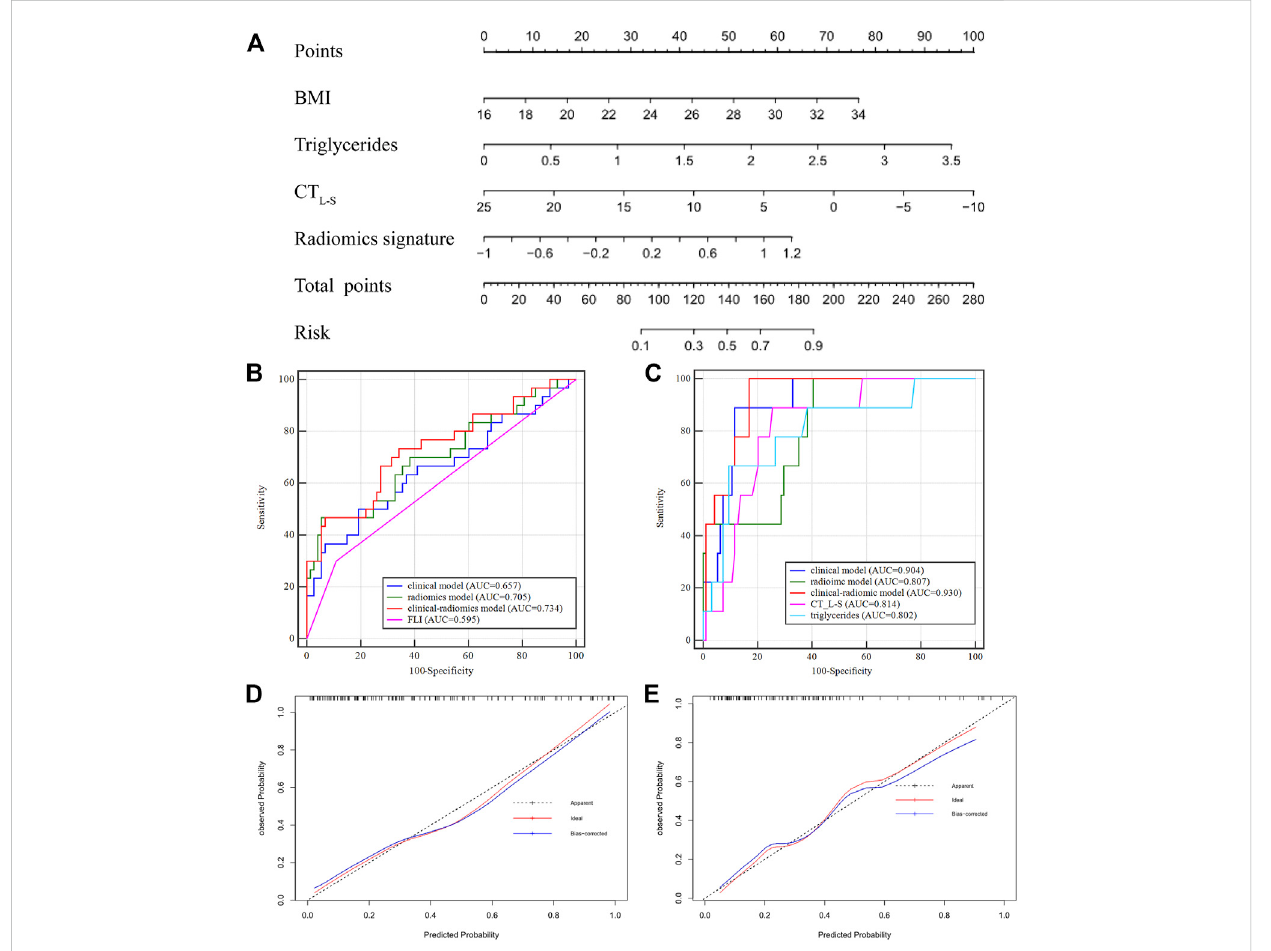
FIGURE 5 Nomogram developed with receiver operating characteristic curves and calibration curves. (A) A clinical-radiomic nomogram for distinguishing nonefromsteatosisbasedonthetrainingcohort,withBMI,triglycerides,CT L-S andradiomicssignatureincorporated. (B) ComparisonofROCcurveinthe validation cohort ofGroup One(S0vs.S1-S3) (C) comparison ofROC curveinthevalidation cohortofGroupTwo(S0-S1 vs . S2-S3).Calibration curves of the validation cohort in Group One (D) and Group Two (E)